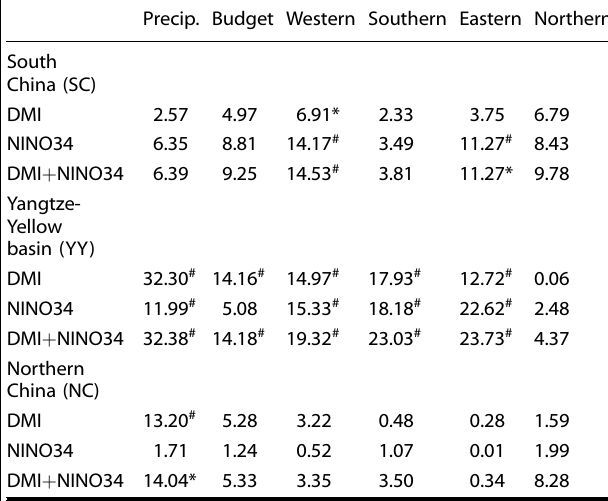
Table 2. Water vapor budget analysis based on key regions (fraction of explained variance,